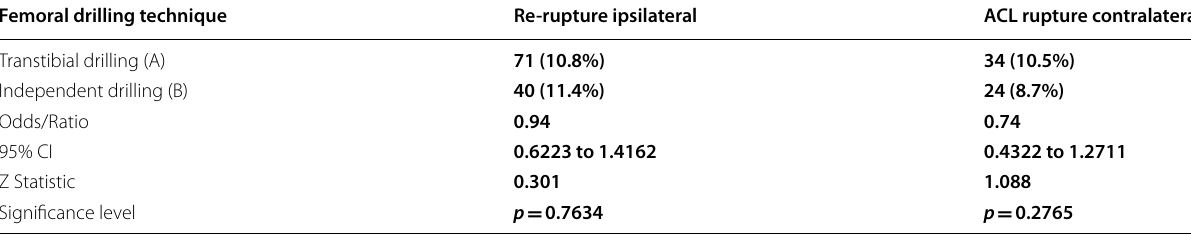
Table 2 Comparison of re-rupture rates between transtibial and independent femoral drilling techniques Femoral drilling technique Transtibial drilling (A)